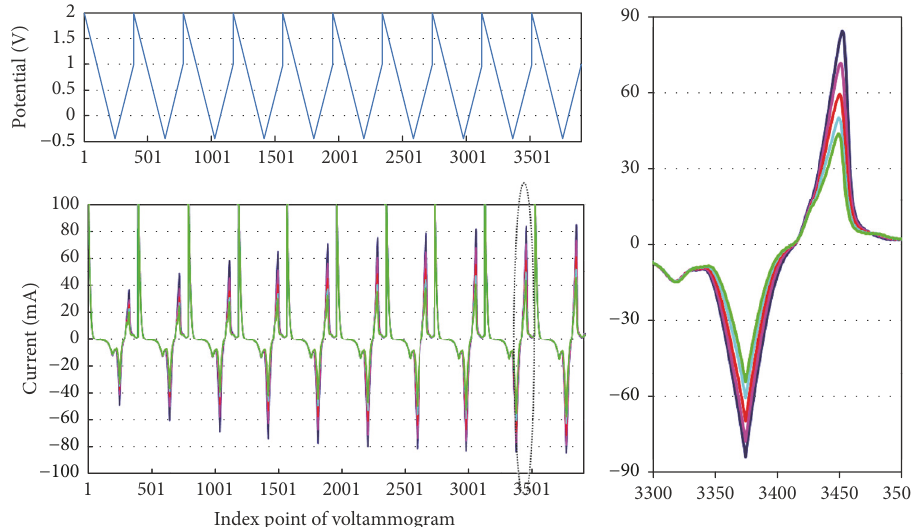
Figure 1: Multicyclic staircase voltammograms ( Δ𝐸 = 10 mV, Δ𝑡 = 1ms) of the training set corresponding to various concentrations of suppressor: 5.00 (dark blue, soln. C1 in Table 1), 6.00 (magenta, C8 ), 7.00 (red, C15 ), 8.00 (light blue, C19 ), and 9.00 (green, C21 ) mLL −1 . Magnified portion corresponding to the ninth